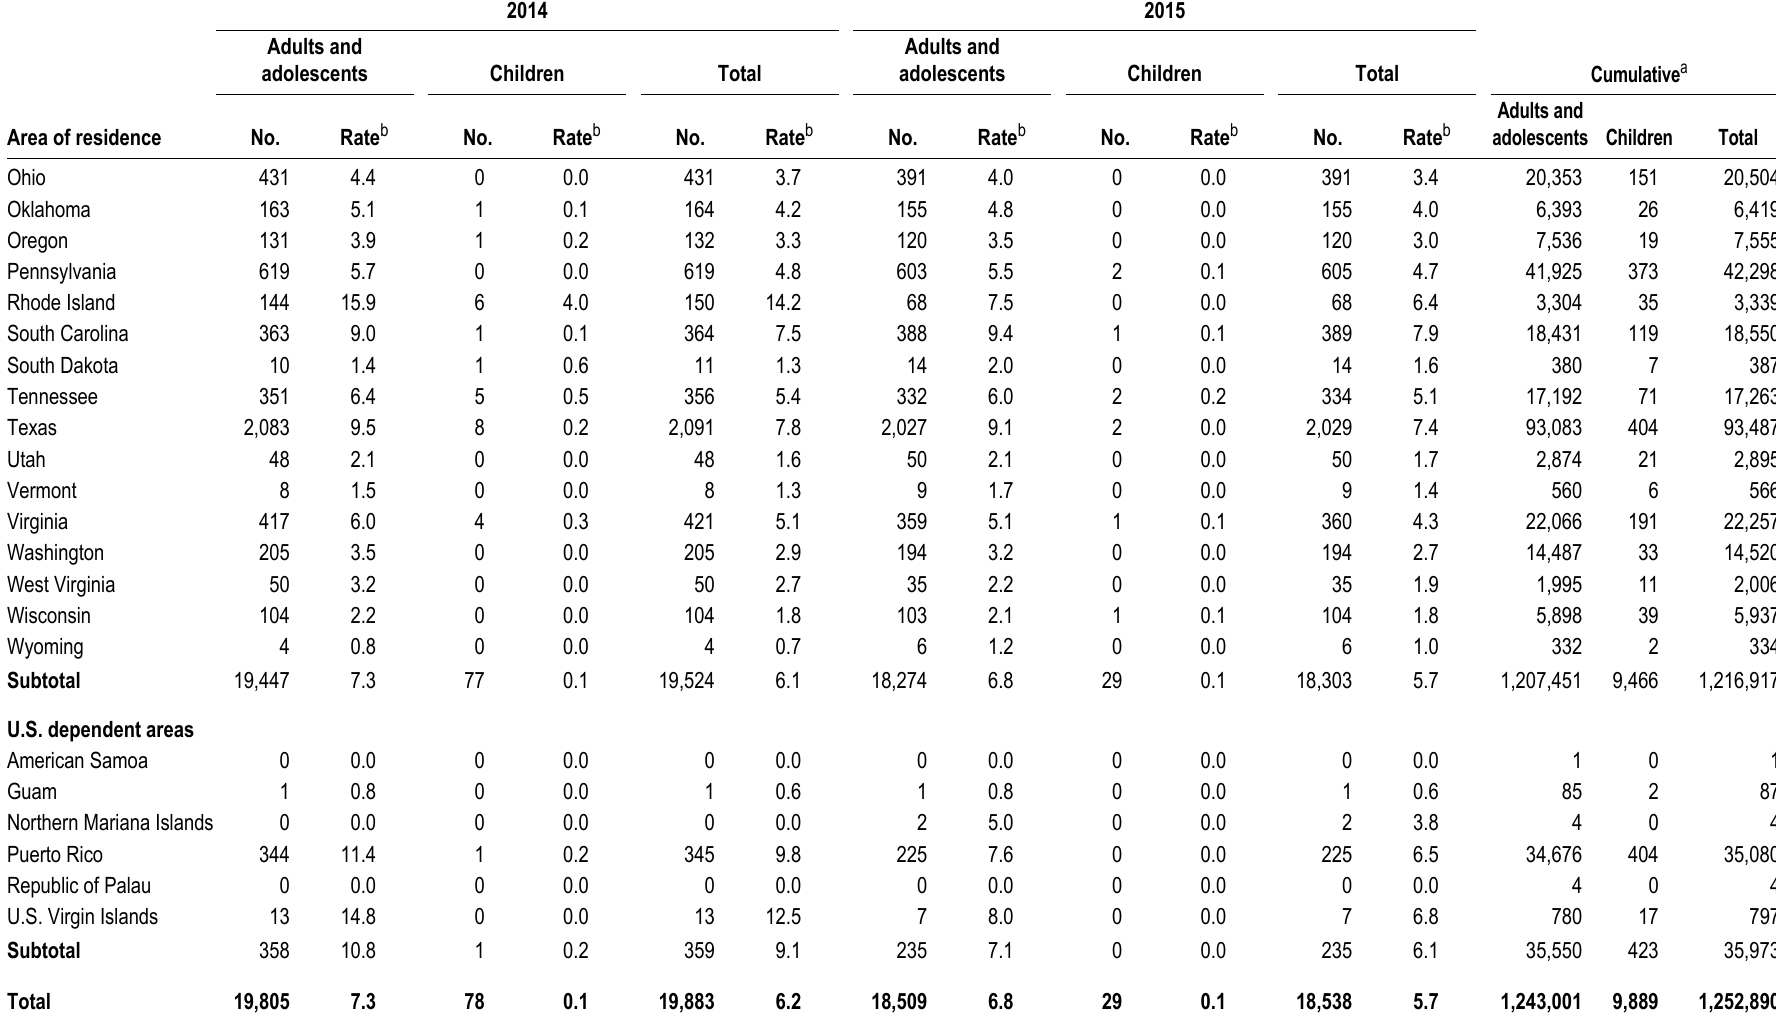
Table 23. Stage 3 (AIDS), by area of residence, 2014, 2015, and cumulative—United States and 6 dependent areas